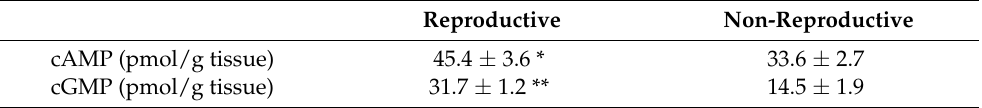
Table 1. cAMP and cGMP levels in reproductive and non-reproductive testes of quail C. coturnix .